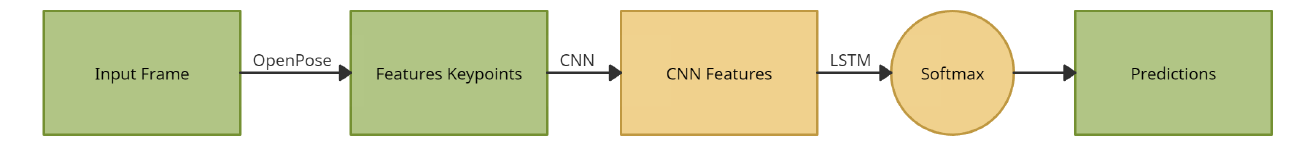
Figure 1. Methodology of the proposed skeleton based CNN-LSTM HAR system. Each frame’s output from the LSTM layer is sent to a time-distributed fully connected layer with number of outputs depending on the number of classes and Softmax activation. Each of these eighteen outputs tells you, in terms of cross-entropy, how likely it is that the corresponding action is being